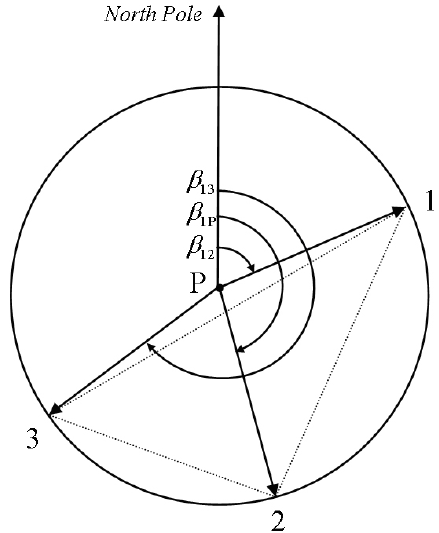
Fig. 8. The simple unit circle model for choosing the best combi- nation of three sensors. P is the lightning location, and β denotes azimuth. Number 1, 2, and 3 is the projection of sensor #1, #2, and #3 on the unit circle,